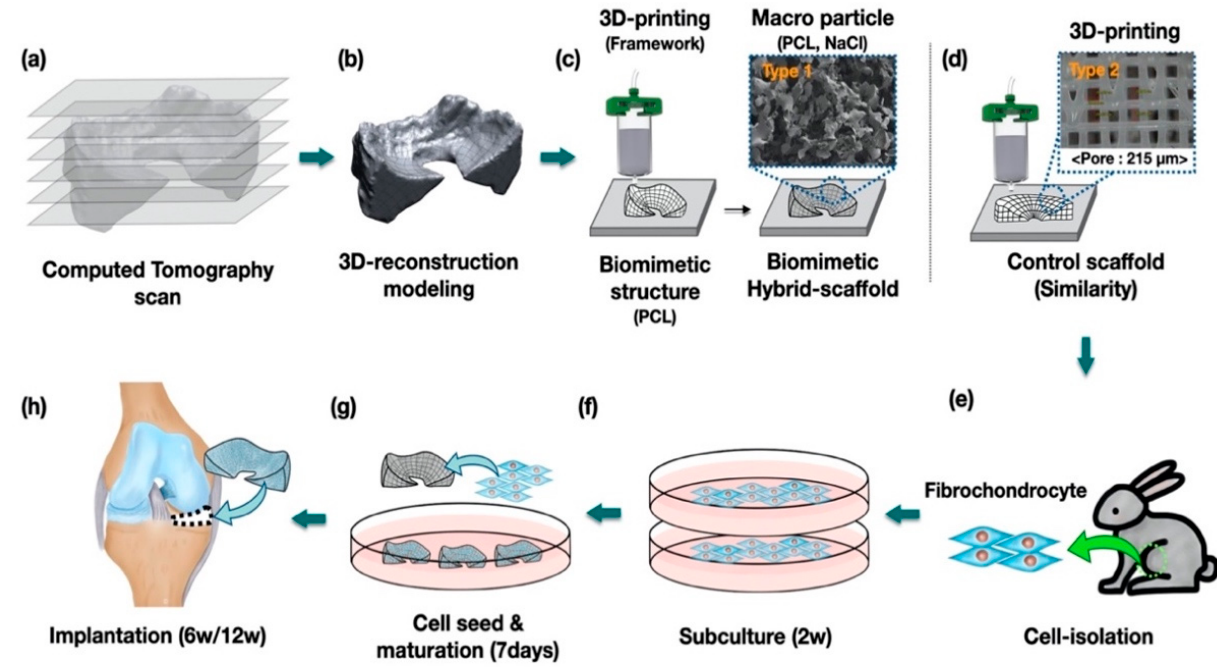
Figure 1. Study design and the process of preparing the hybrid-scaffold. Procedure of the ( a – d ) fabricated the biomimetic hybrid-, control scaffold, ( e – g ) cell culture and ( h ) implantation.